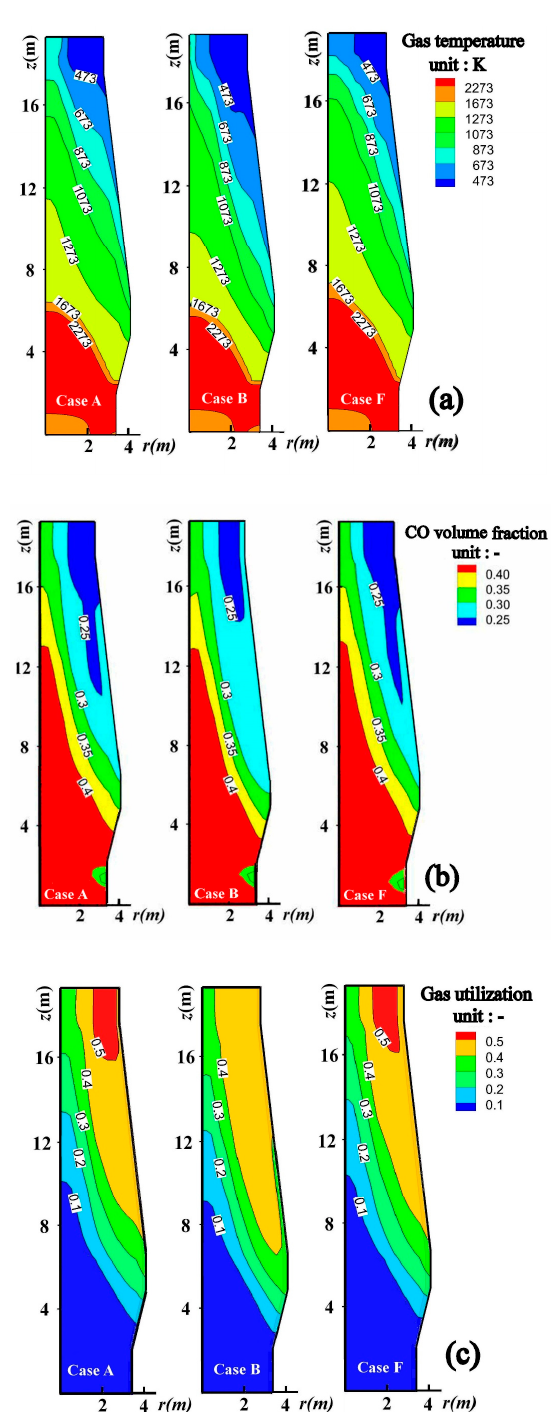
Figure 4. Simulation results of gas phase in the BF of cases A, B, and F: ( a ) Profile of gas-phase temperature; ( b ) profile of CO volume fraction; and ( c ) profile of local gas utilization.